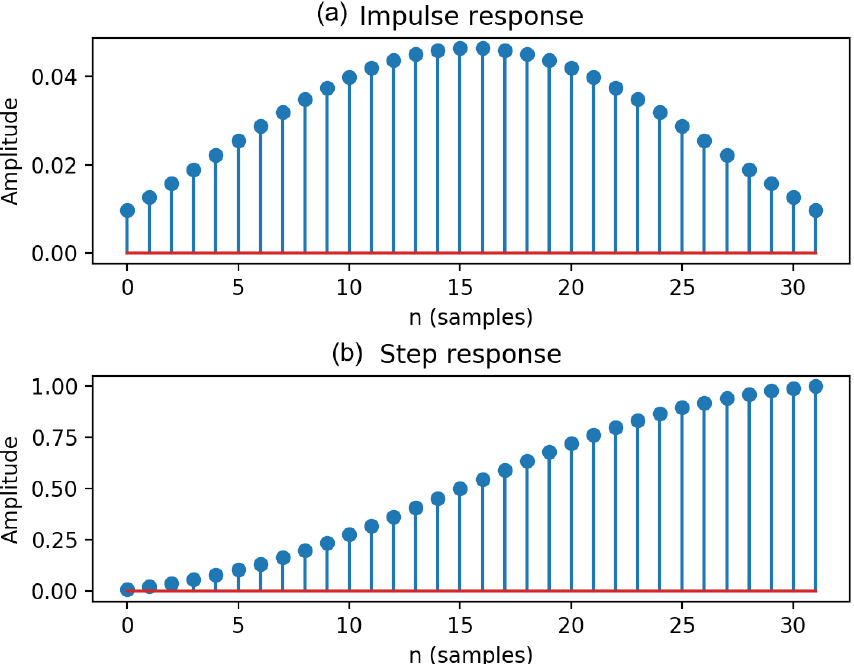
Figure 7. Responses of finite impulse filter: (a) impulse response and (b) step